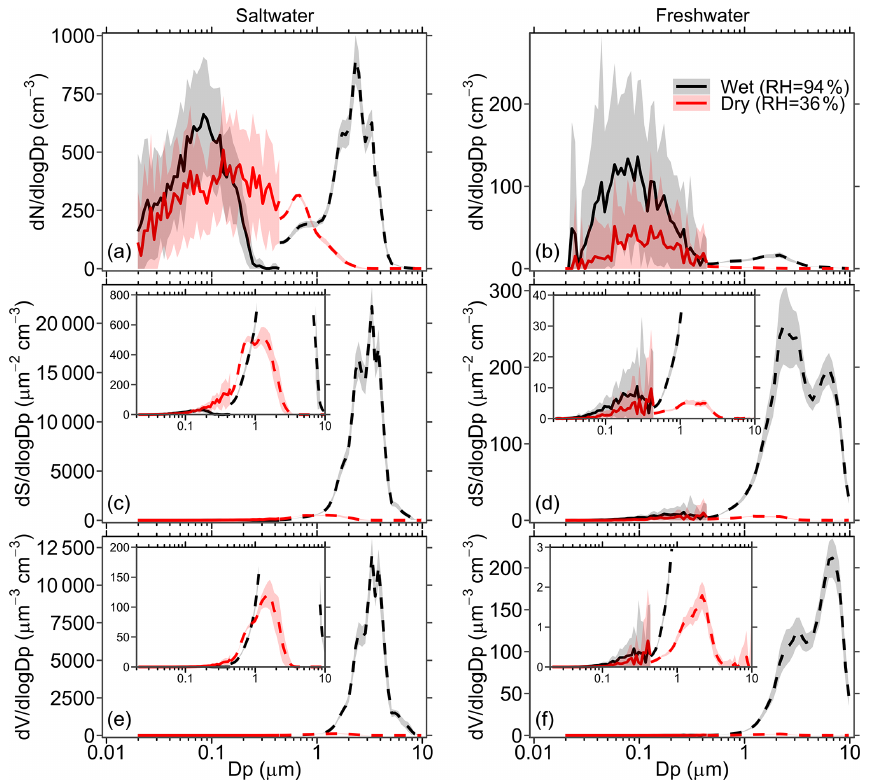
Figure 3. The synthetic saltwater and freshwater average aerosol (a, b) number, (c, d) surface area, and (e, f) volume size distributions of dry and wet aerosols, corresponding to sampling with and without a dryer, respectively. Shaded areas represent ± 1 standard deviation. Insets show a close-up of the dry surface area and volume size